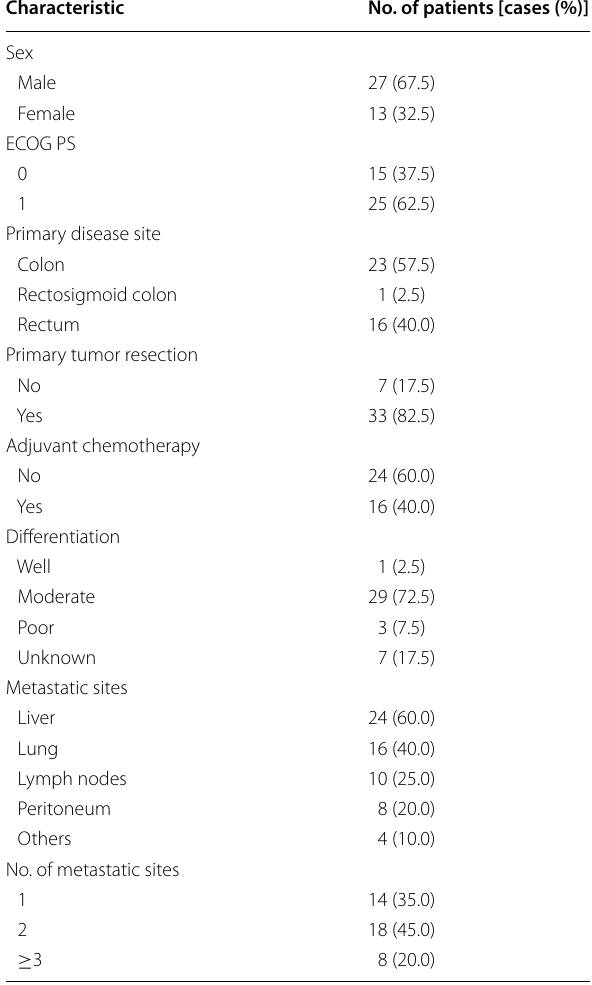
of enrolled patients with